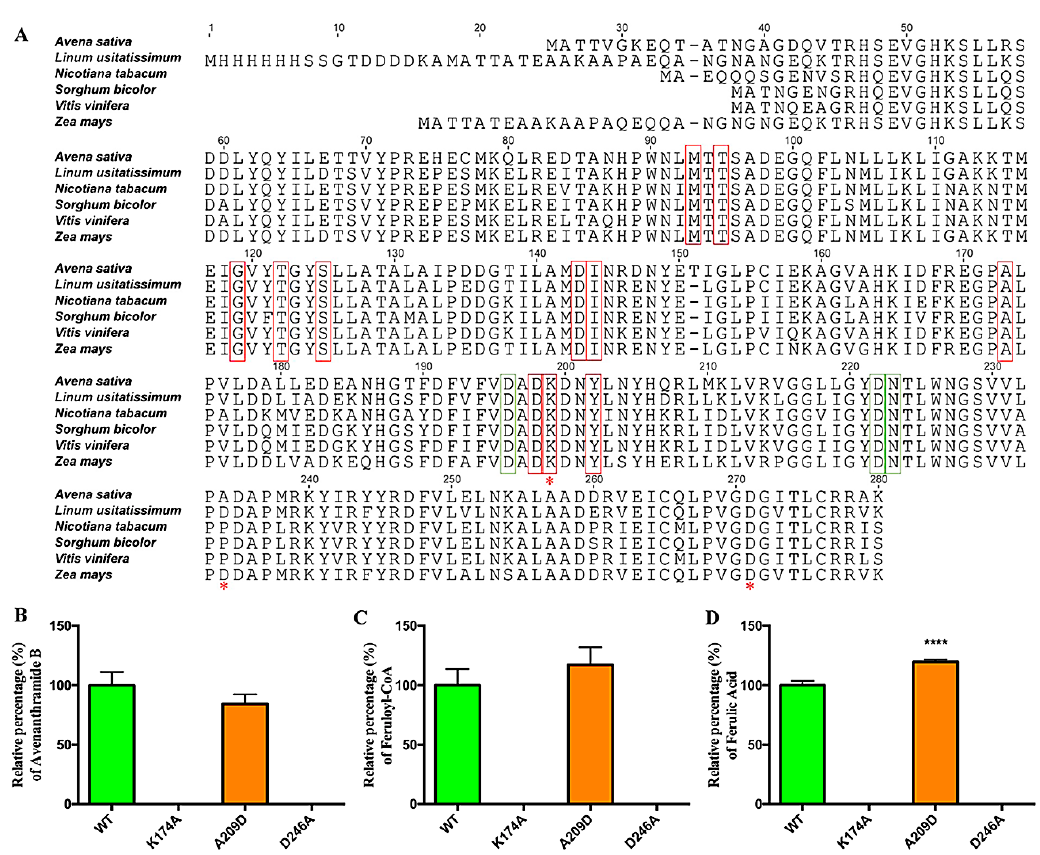
Figure 4. Mutagenesis analysis of the oat CCoAOMT enzyme. ( A ) Sequence alignment of oat CCoAOMT sequence and related sequences. Conserved residues involved in SAM binding were highlighted in red boxes. Residues involved in divalent binding were highlighted in green boxes. The loop region was between N227 to L250. Mutation site were marked by red * . Changes in the activity of native and mutagenized CCoAOMT proteins on three substrates avenanthramide C ( B ), caffeoyl-CoA ( C ), and caffeic acid ( D ) were calculated using the average of three biological triplicate measurements.